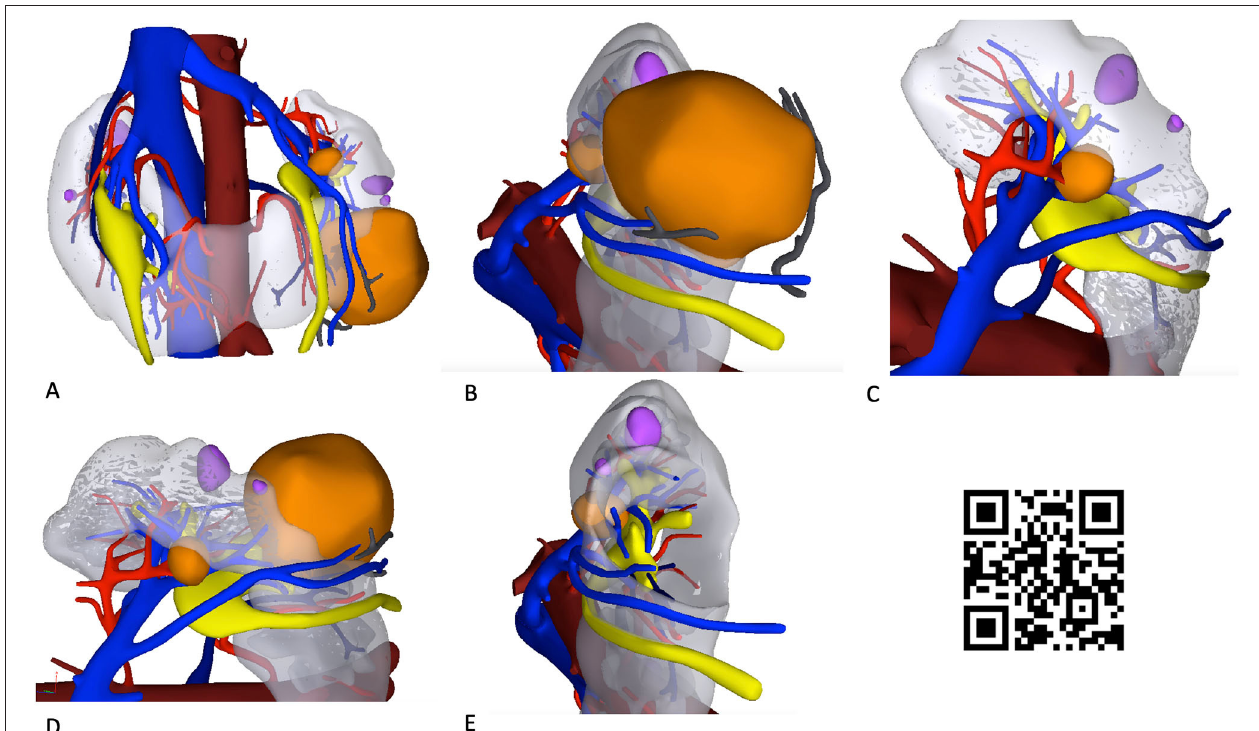
FIGURE 1 | Hyperaccuracy three-dimensional (HA3D) virtual model of the two renal masses in a patient with a horseshoe kidney (HSK). The snapshots (A–E) show the anatomical relationships of the two renal masses (colored orange) with the extra- and intra-renal vascular (veins, in blue; arteries, in red) and urinary structures (in yellow). Simple renal cysts are colored violet. A linked video clip is available scanning the QR code on the right side of the image. For apple users: open the Camera app from your devices. Hold your device so that the QR code appears in the Camera app’s viewfinder. Your device recognizes the QR code and shows a notification. Tap the notification to open the link associated with the QR code. For Android users: download a QR code scanner app and follow the above